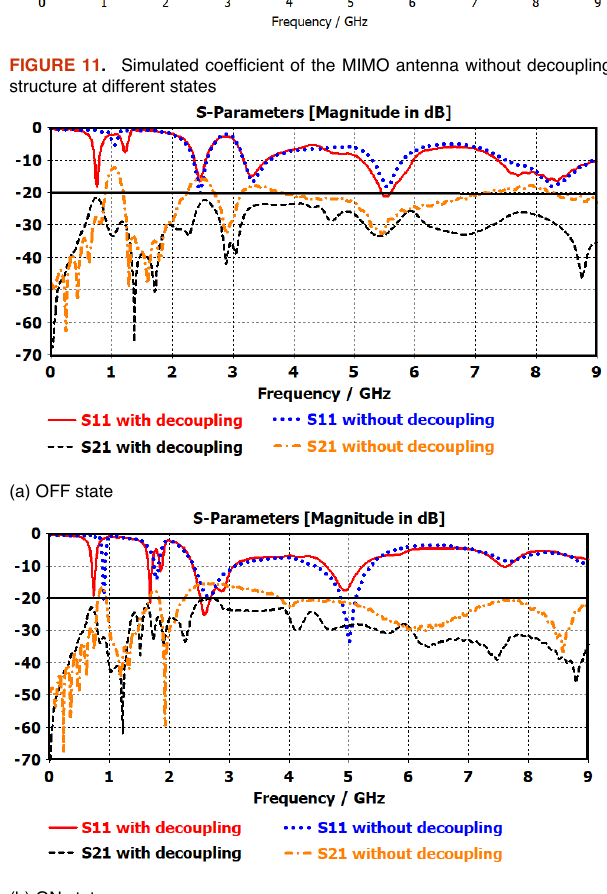
FIGURE 11. Simulated coefficient of the MIMO antenna without decoupling structure at different states